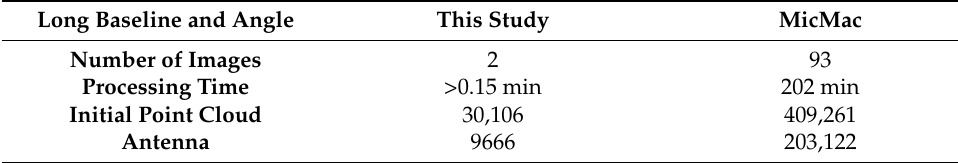
Table 8. Input and output overview of case 2.